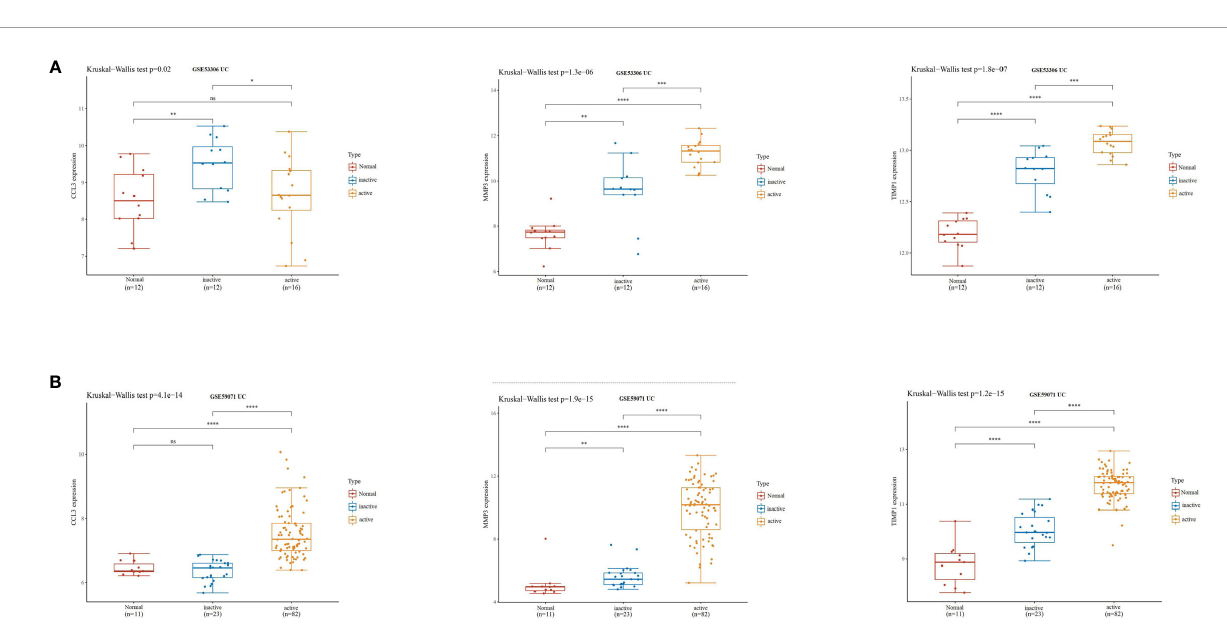
FIGURE 4 CCL3, MMP3, and TIMP1 expression levels in patients with active UC. (A) The expression of CCL3, MMP3, and TIMP1 in the GSE53306 dataset. (B) The expression of CCL3, MMP3, and TIMP1 in the GSE59071 dataset. "*" corresponds to a signi fi cant level of 5%, that is, p<0.05. p<0.05 indicates that the difference is 95% certain and has statistical signi fi cance. "**" corresponds to a signi fi cant level of 1%, that is, p<0.01, which indicates that the difference is 99% certain, and the difference is signi fi cant, with statistical signi fi cance. "***" corresponds to a signi fi cant level of 0.1%, that is, p<0.001. p<0.001 indicates that the difference is 99.9%, which is very signi fi cant and statistically signi fi cant. ns means no statistical signi fi cance.